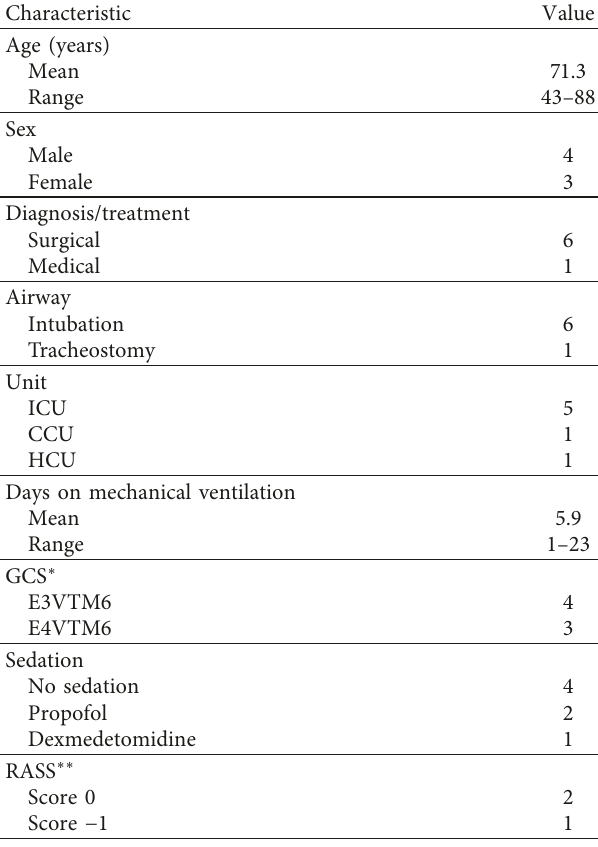
Table 1: Characteristics of patients ( n � 7).